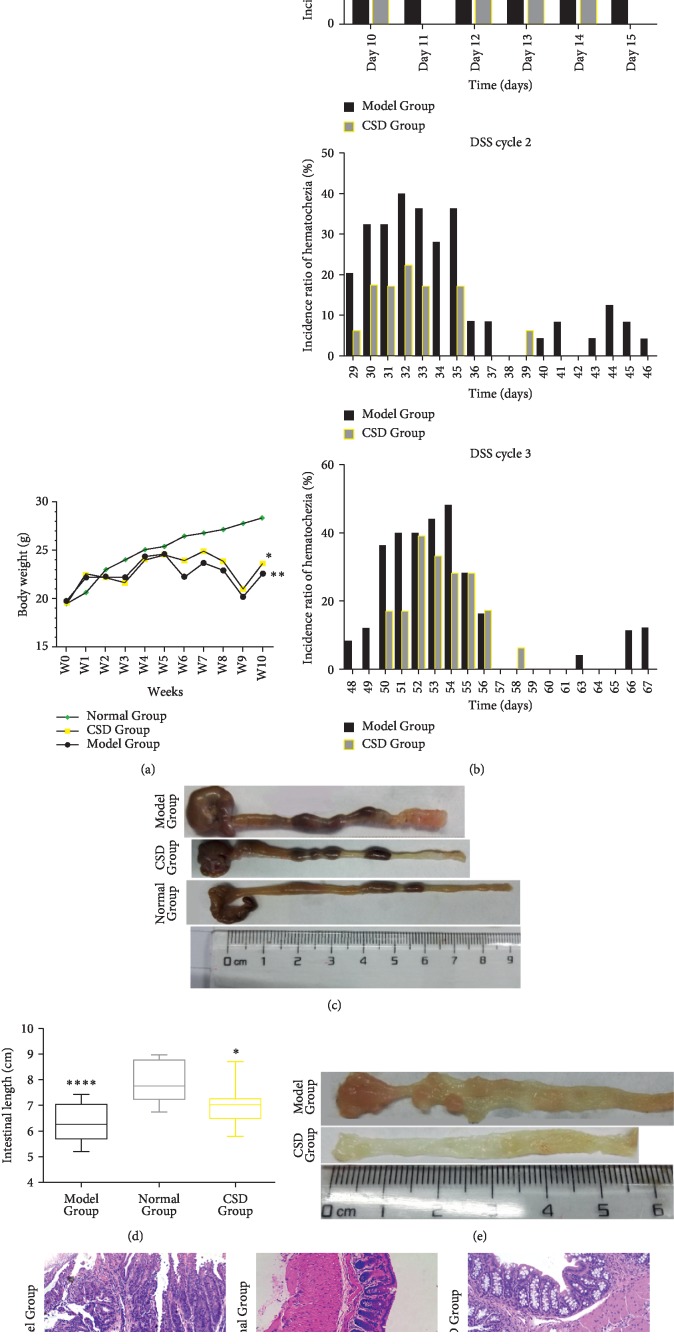
CSD overcomes AOM/DSS-induced malignancy of colon. (a) Body weight per mouse measured per day during all the experiment. ∗p < 0.05, ∗∗p < 0.01, significantly different from the Normal Group. (b) Effect of CSD on the incidence ratio of hematochezia. ∗p < 0.05 vs. Model Group. (c) Colonic length of mice from the three groups. (d) Comparison of colon length among the three groups, ∗p < 0.05, ∗∗p < 0.01 vs. Normal Group. (e) Effect of CSD on multiplicity of polyp/adenoma on colons. (f) Colon sections stained with H&E (×200) from each group.